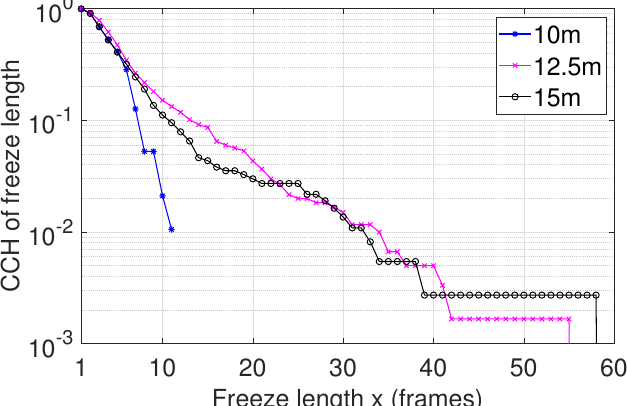
Figure 10. CCH of freeze length accumulated over the four